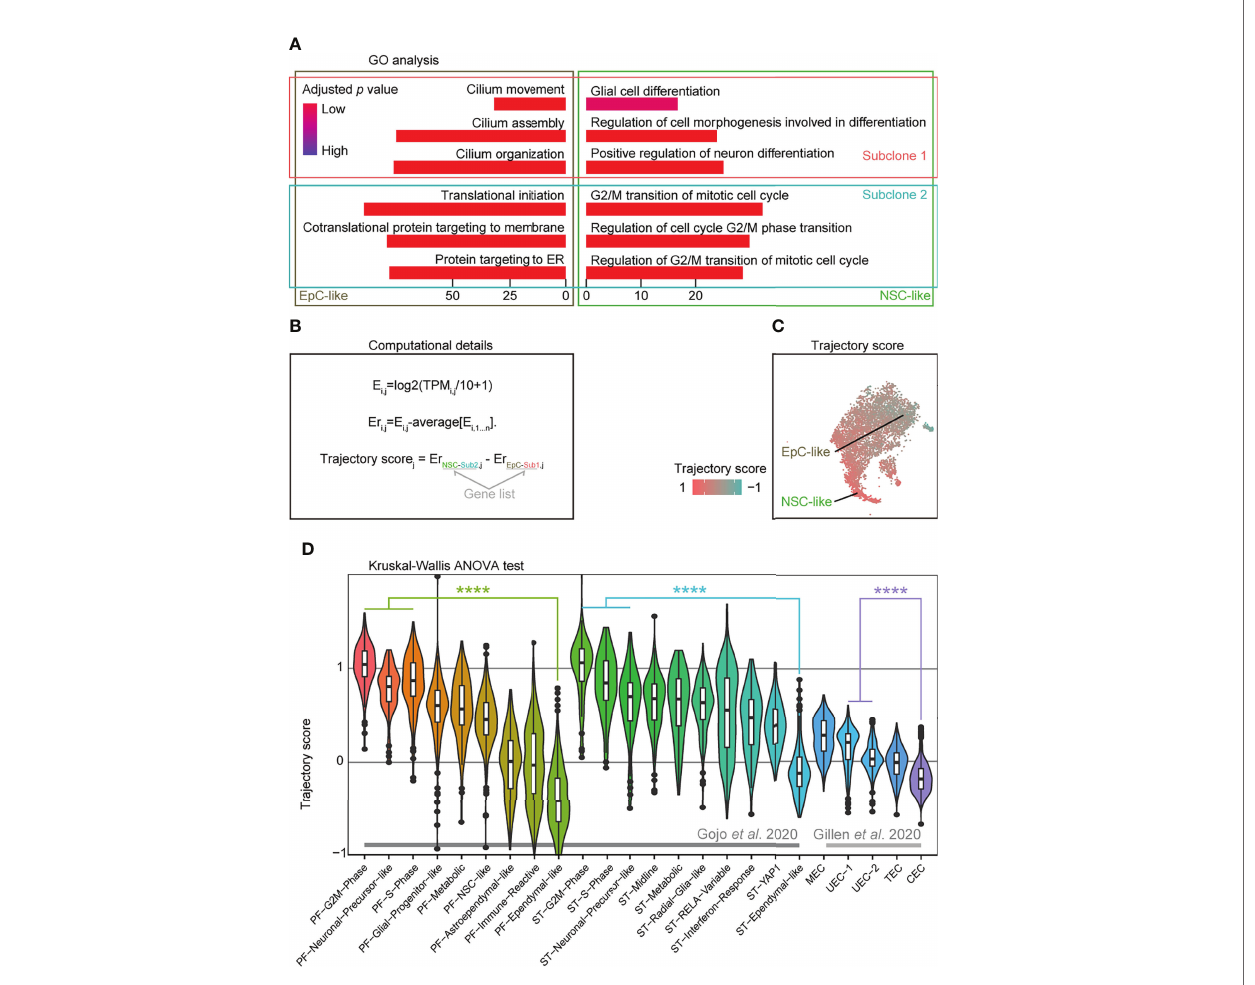
FIGURE 3 | Trajectory score analysis can predict EPN cell compositions associated with poor survival outcomes. (A) Gene ontology analysis of differentially expressed genes from EpC- and NSC-like cells between subclones classi fi ed by annotation of subclones and cell types in PF-EPN sample GTE009. (B) Work fl ow for calculating trajectory score based on published computation method (30). E, expression; TPM i,j , transcript per million (TPM) for gene i in sample j; Er, relative expression. (C) tSNE plot of trajectory score in combined subclone 1 and 2 datasets with EpC- and NSC-like cell populations labeled in the PF-EPN sample GTE009. (D) Validation of trajectory score on published scRNA-seq data (5, 6) of EPN using previously de fi ned cell-type annotations ( p < 0.0001; Kruskal – Wallis test). The "*" means signi fi cant difference (p-value): * p < 0.05; ** P < 0.01; *** p < 0.001; **** p <